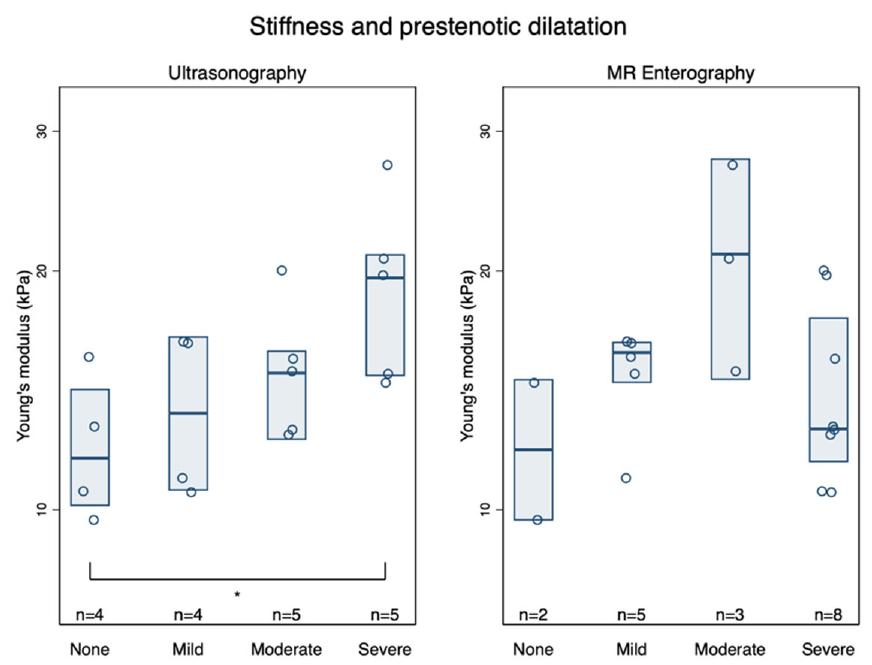
Figure 5. Associations between stiffness of small intestinal strictures and the degree of prestenotic dilatation on ultrasonography ( τ b = 0.43, p = 0.02) ( left ) and MR Enterography ( τ b = 0.01, p = 1.0) ( right ). Boxes are median and inter-quartile ranges. * p < 0.05.